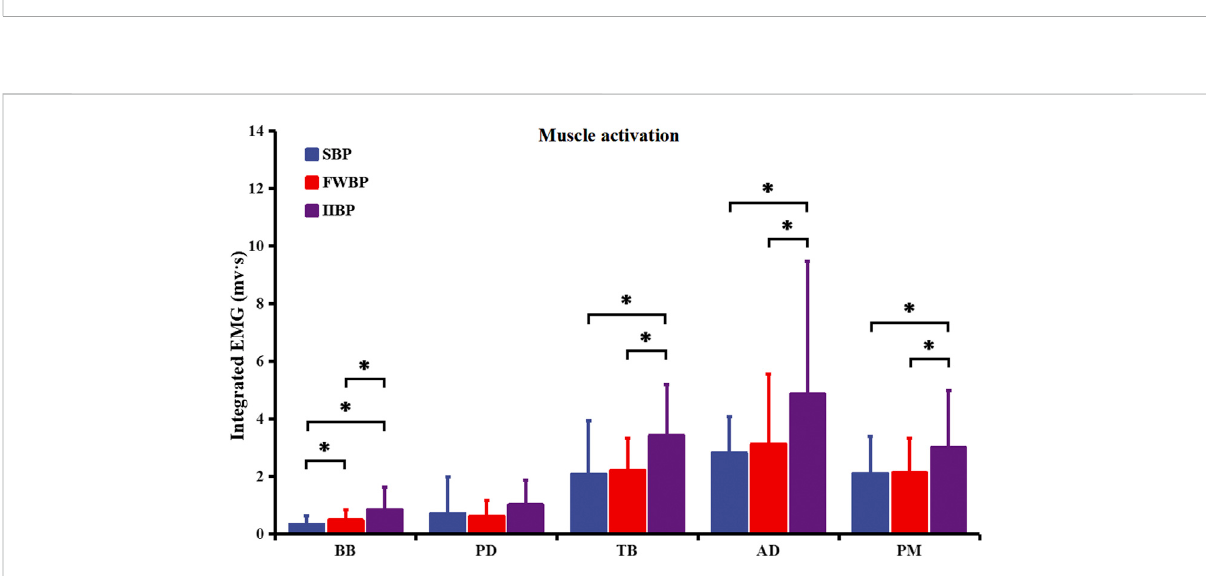
FIGURE 4 Integrated EMG activation of stabilizing muscles (BB and PD) and prime movers (TB, AD, and PM) for three different bench press conditions. Results were expressed as mean ± SD. Signi fi cant differences are indicated by asterisks ( p <